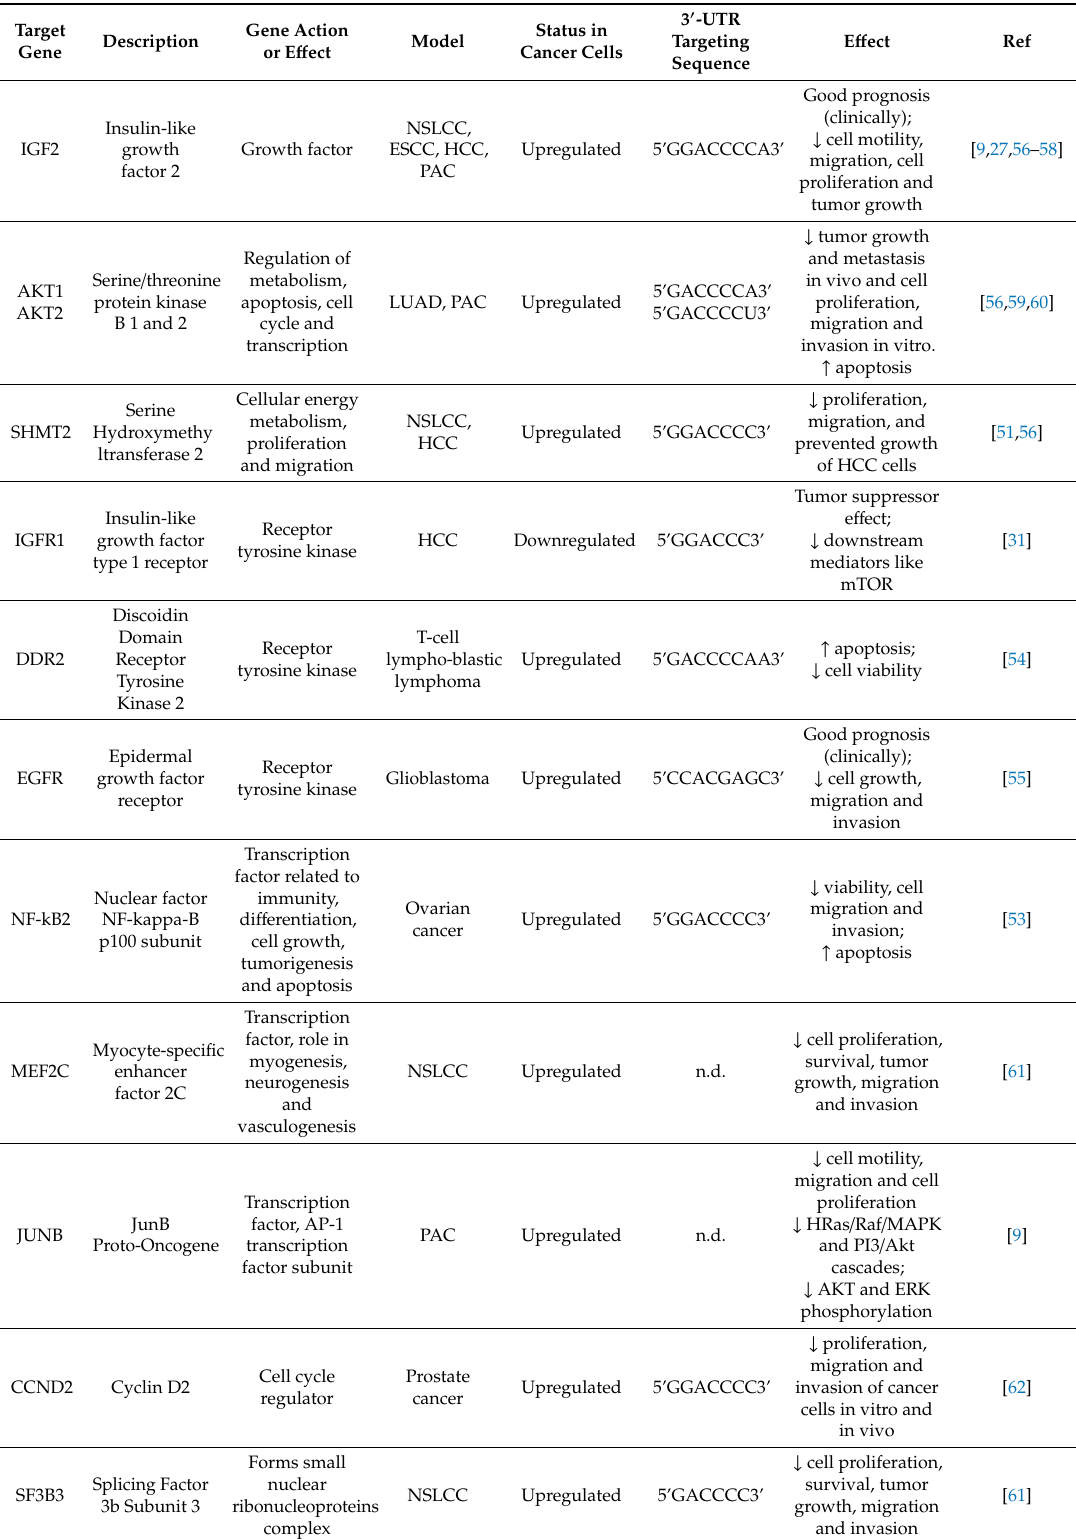
Table 2. Targets directly downregulated by miR-615-5p in